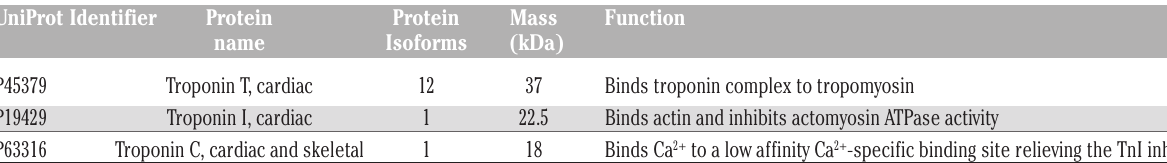
Table 3. Troponin proteins expressed in the